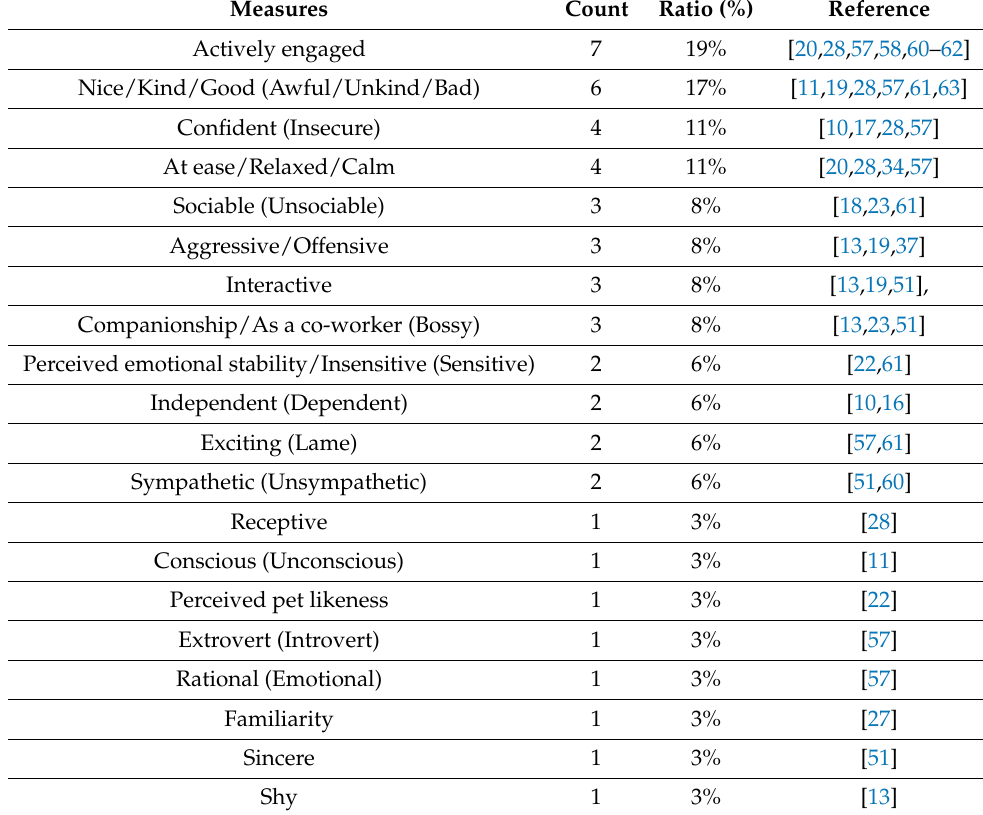
Table 8. Personality of a